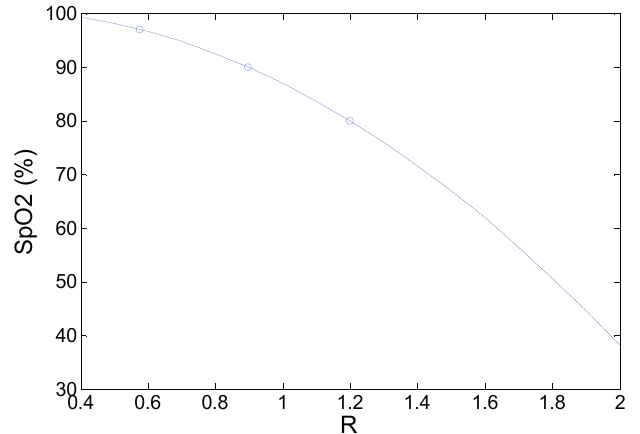
Figure 5. Second-order empirical calibration curve relating the absorbance ratio (R) from the CMOS sensor to the SpO2 level of the “BC biomedical FingerSim” phantoms in transmission mode.